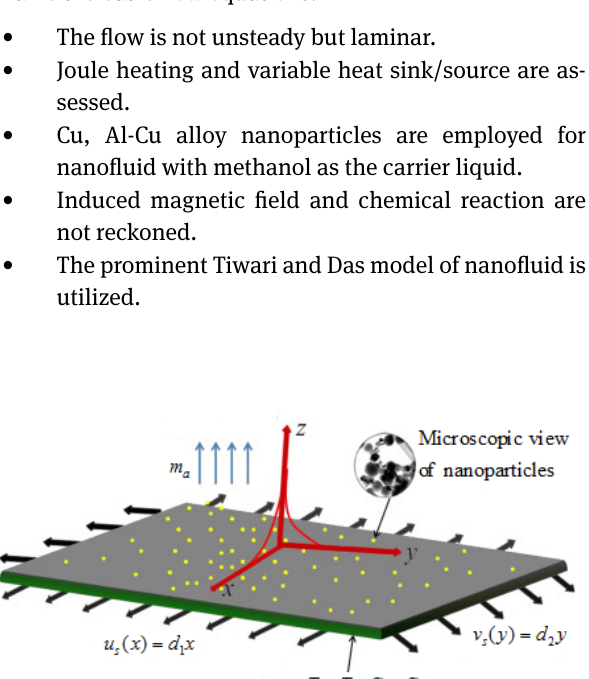
Fig. 1: Flow Geometry